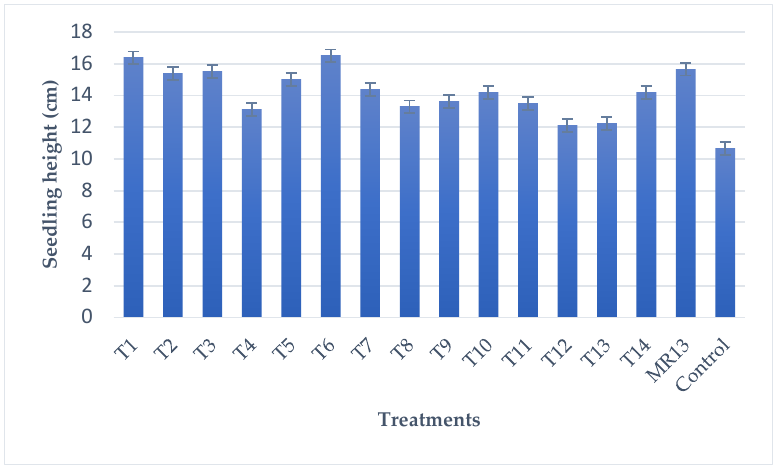
Figure 1. Relative chlorophyll content of chilli seedlings treated with endophytic bacteria and moringa leaf extract using various extraction methods. The values are an average of five independent measurements.